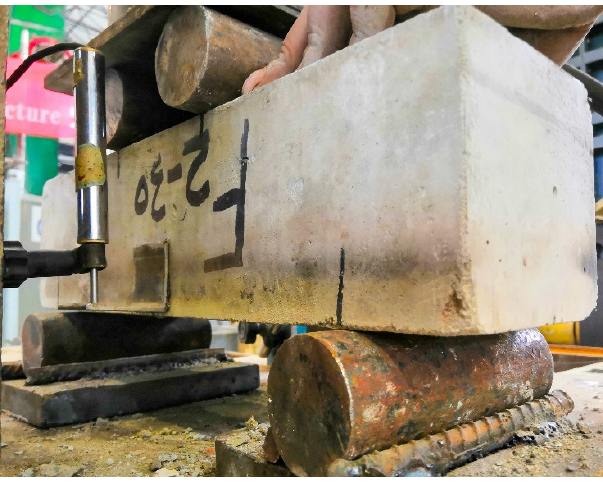
Figure 6. Setup chart of flexural toughness loading.